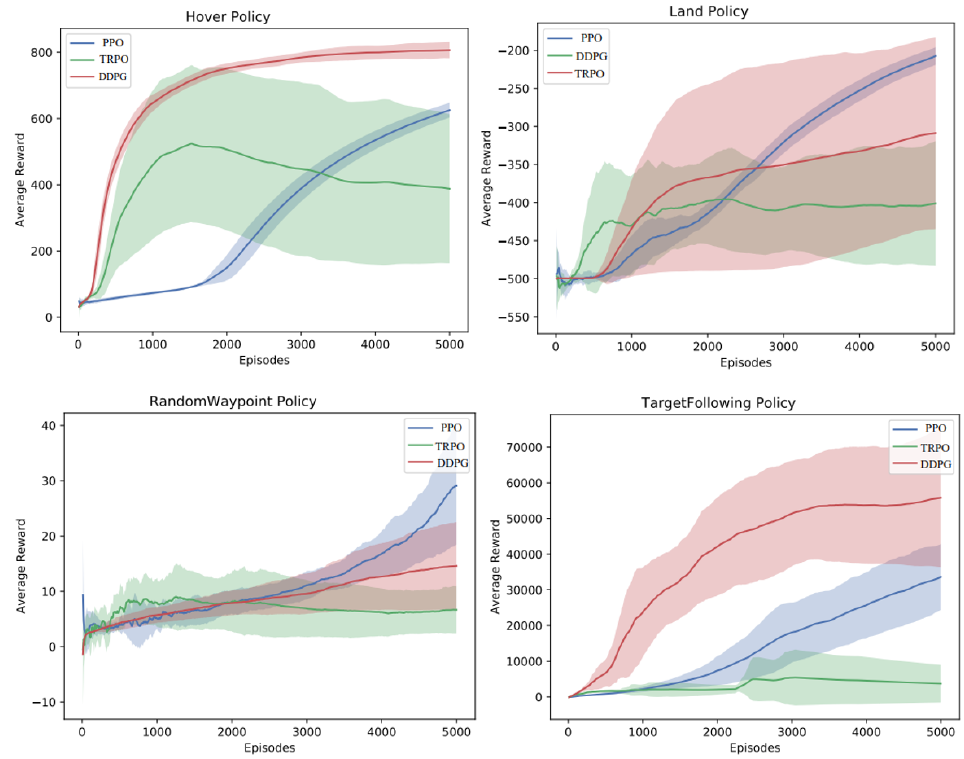
Figure 8. Average reward for the hover, land, random waypoint and target following tasks over 5000